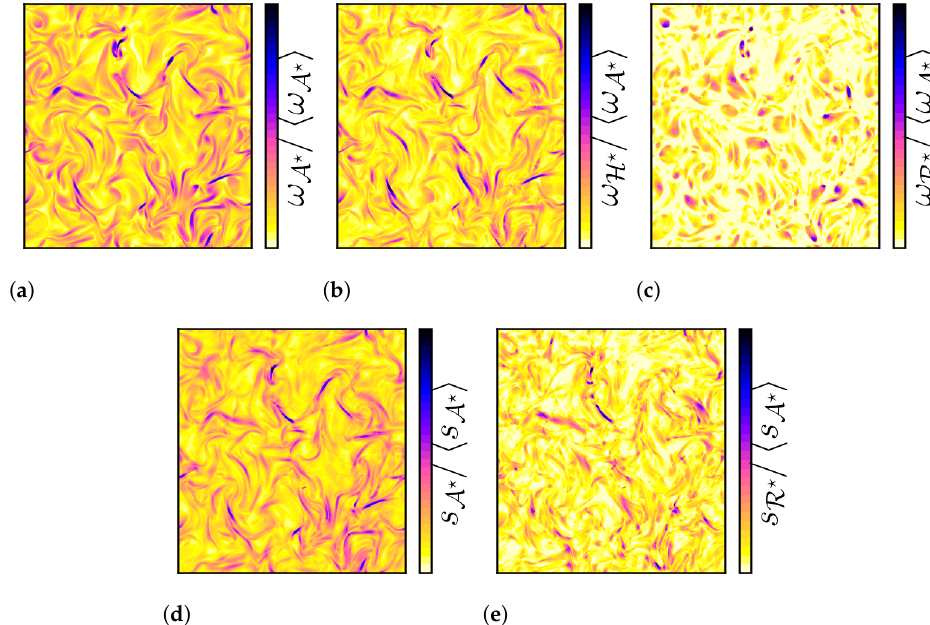
Figure 8. Color contour of the normalized ( a ) ω A (cid:63) and ( d ) s A (cid:63) and their components ( b ) ω H (cid:63) , ( c ) ω R (cid:63) , and ( e ) s N (cid:63) on the x 1 - x 2 plane for Ma t =